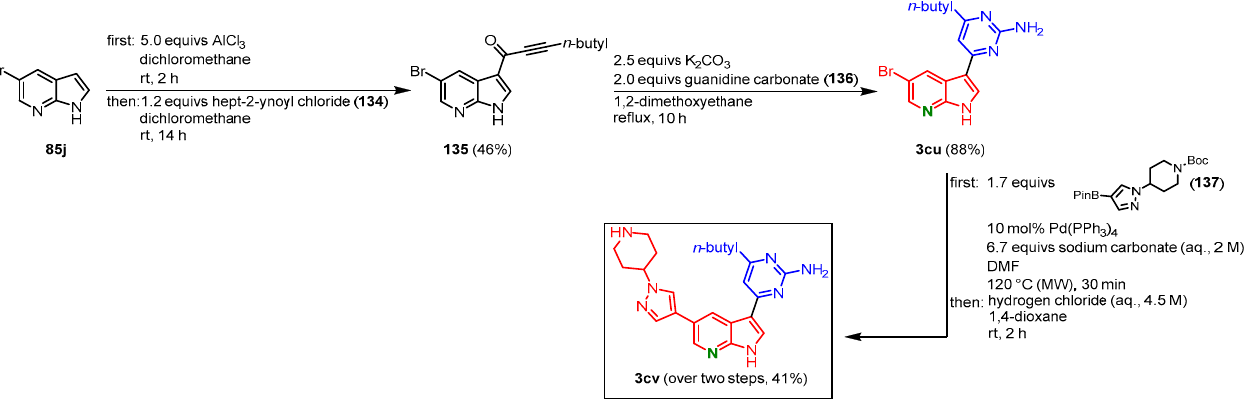
Figure 37. Preparation of meriolin 3cv via Friedel Crafts acylation by Grädler [68].